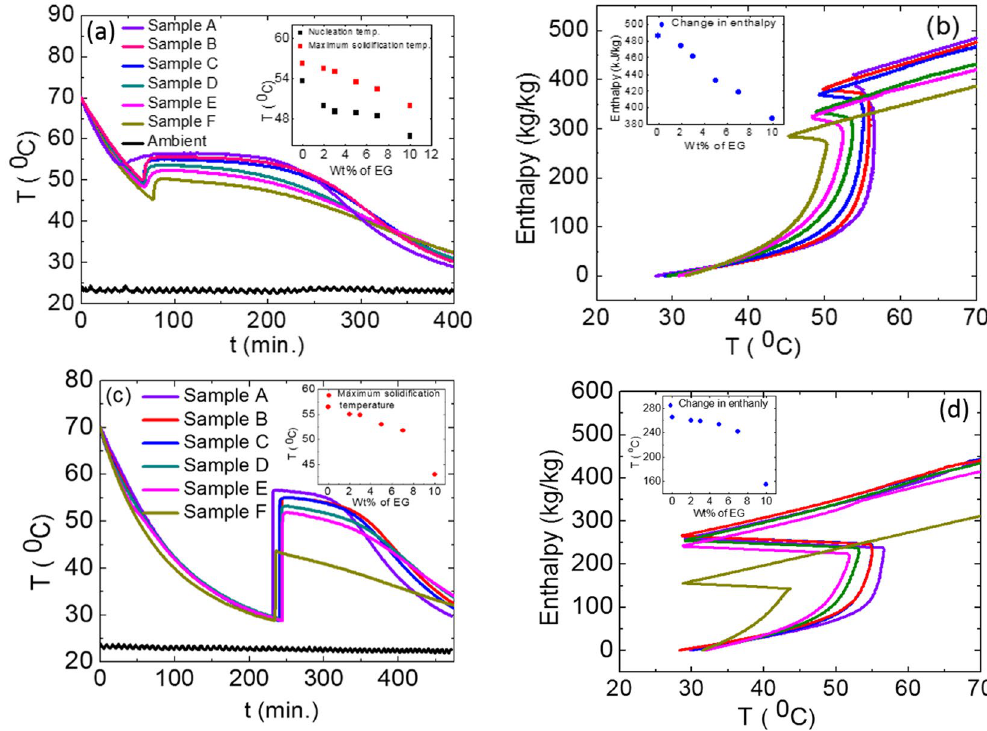
Figure 5. ( a ) T-history graphs for samples A, B, C, D, E and F nucleated at 60 °C and ambient temperature ~23 °C, ( b ) enthalpy vs. temperature curves corresponding to graph 5( a ), ( c ) T-history graphs for samples A, B, C, D, E and F nucleated at ~30 °C and ambient temperature ~23 °C, ( d ) enthalpy vs. temperature curve corresponding to graph 5( c